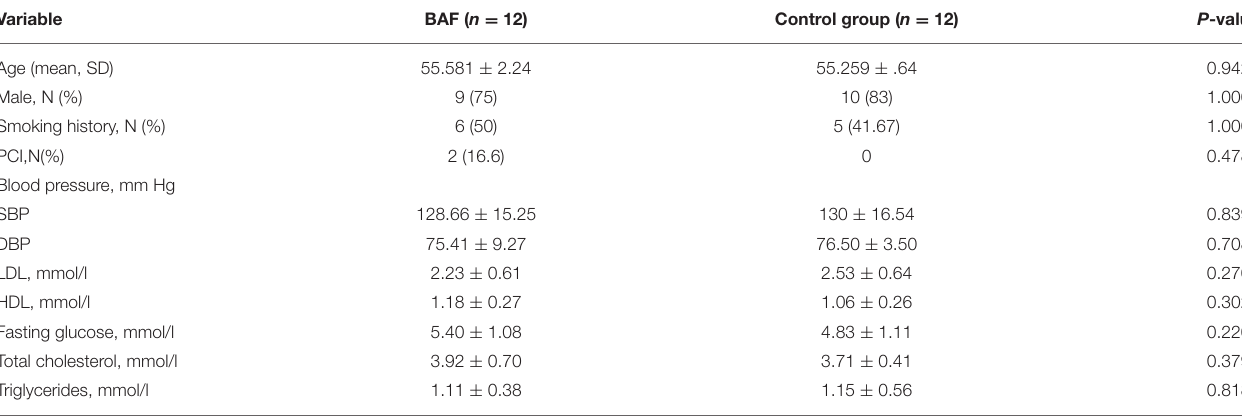
TABLE 1 | Patient baseline characteristics between the BAF and control group. Variable